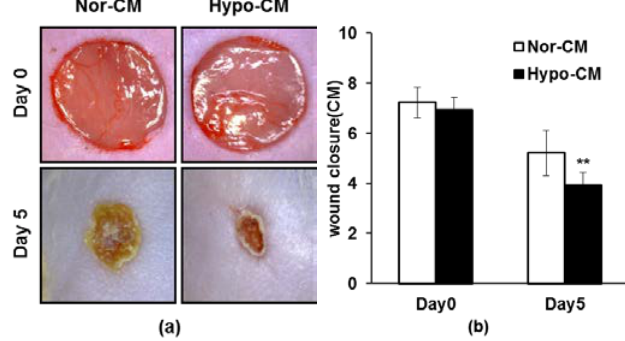
Figure 5. The effect of AF-MSC-hypoCM on wound closure. ( a ) Representative images of wounds after 5 days of treatment, showing that the wound sizes were observably decreased in response to AF-MSC-hypoCM; ( b ) Measurement of wound sizes treated with AF-MSC-norCM and AF-MSC-hypoCM, respectively, showing that wound closure was significantly increased in response to AF-MSC-hypoCM at day 5; ( c ) Histomorphometric analysis of wound closure showed that AF-MSC-hypoCM treated mice revealed significant improvement compared to AF-MSC-norCM treated mice at day 20; and ( d ) Immunohistochemistric analysis of wounded skin showed that AF-MSC-hypoCM treatment increased obviously the expression of ECM marker (fibronectin) and AKT, PI3K and SMAD2/3 proteins. Representative data from 10 animals per group are shown. Data are expressed as the mean ± SD. ** p <